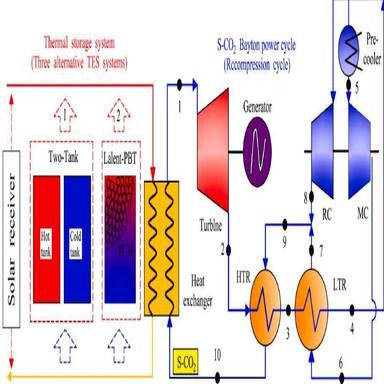
Supercritical CO2 Brayton power cycle with TES system. Adapted from.